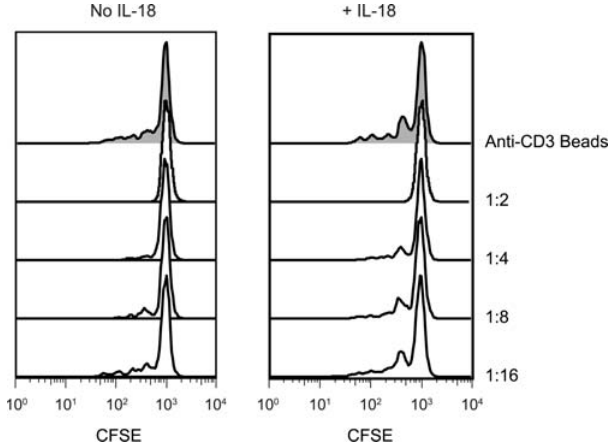
Figure S2 Photomicrographs of gut tissue sections taken from animals after xenogeneic GVHD induction. Sections were obtained from the animals described above in Suppl. Fig. S1.